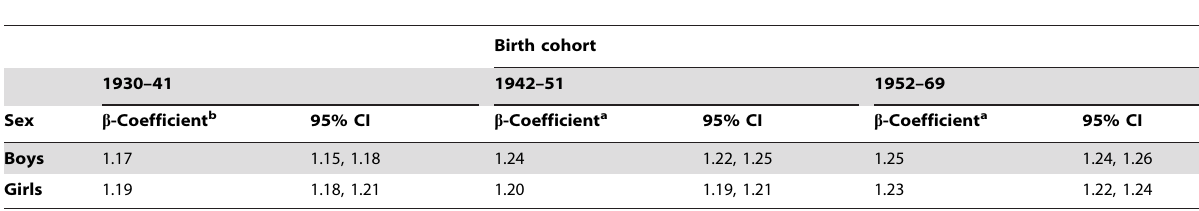
Table 1. BMI at 13 years as a function of BMI at 7 years by sex and birth cohort a .